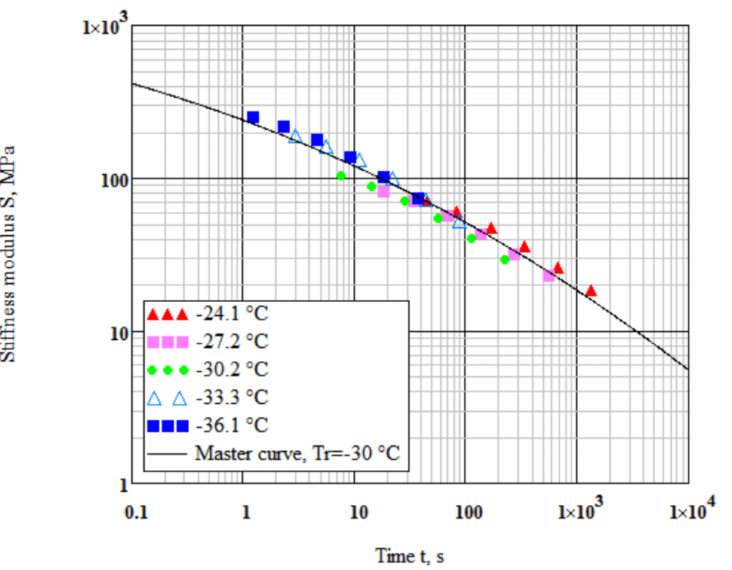
Figure 6. Master curve of stiffness as a function of time for the Elvaloy modified bitumen binder at T r = − 30 ◦ C.